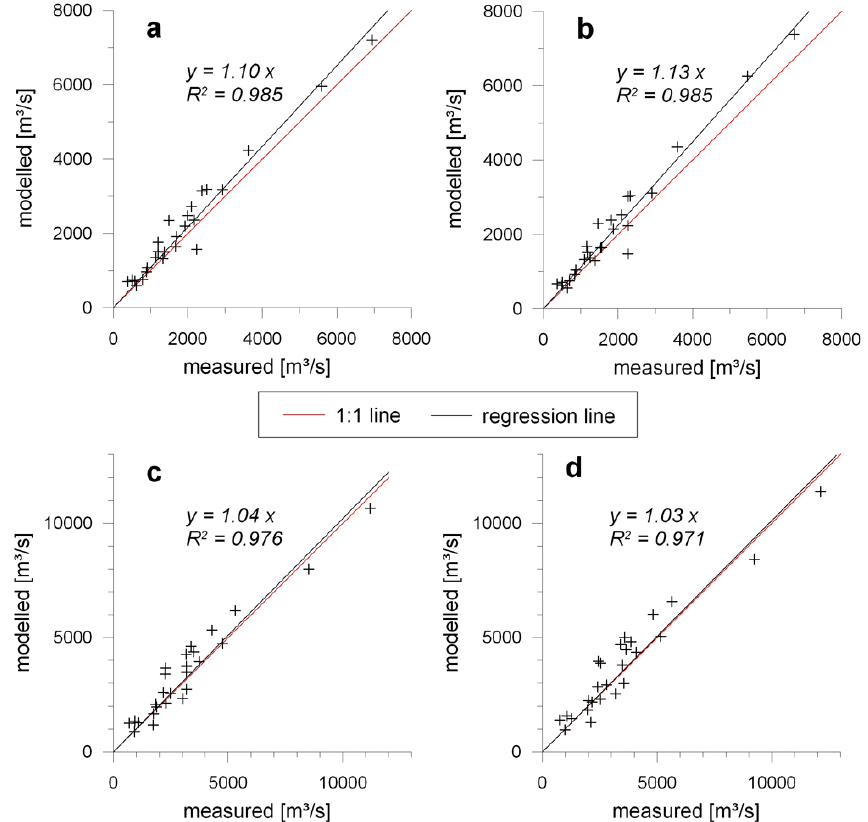
Fig. 2. Comparison of flood indices derived from measured and simulated hydrographs for the reference period 1971–2000: (a) mean annual flood, (b) median annual flood, (c) 25-year flood, and (d) 50-year